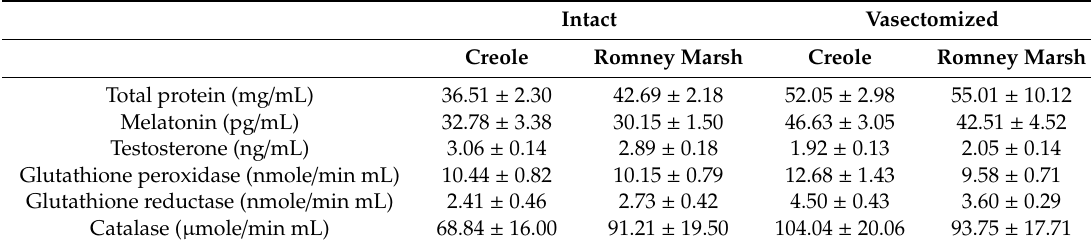
Table A1. Protein, melatonin and testosterone concentration, and antioxidant enzymes activity in seminal plasma of intact and vasectomized rams of two breeds (Creole and Rommey Marsh) located in equatorial photoperiod. Results are shown as mean ± SEM of n = 12 seminal plasma